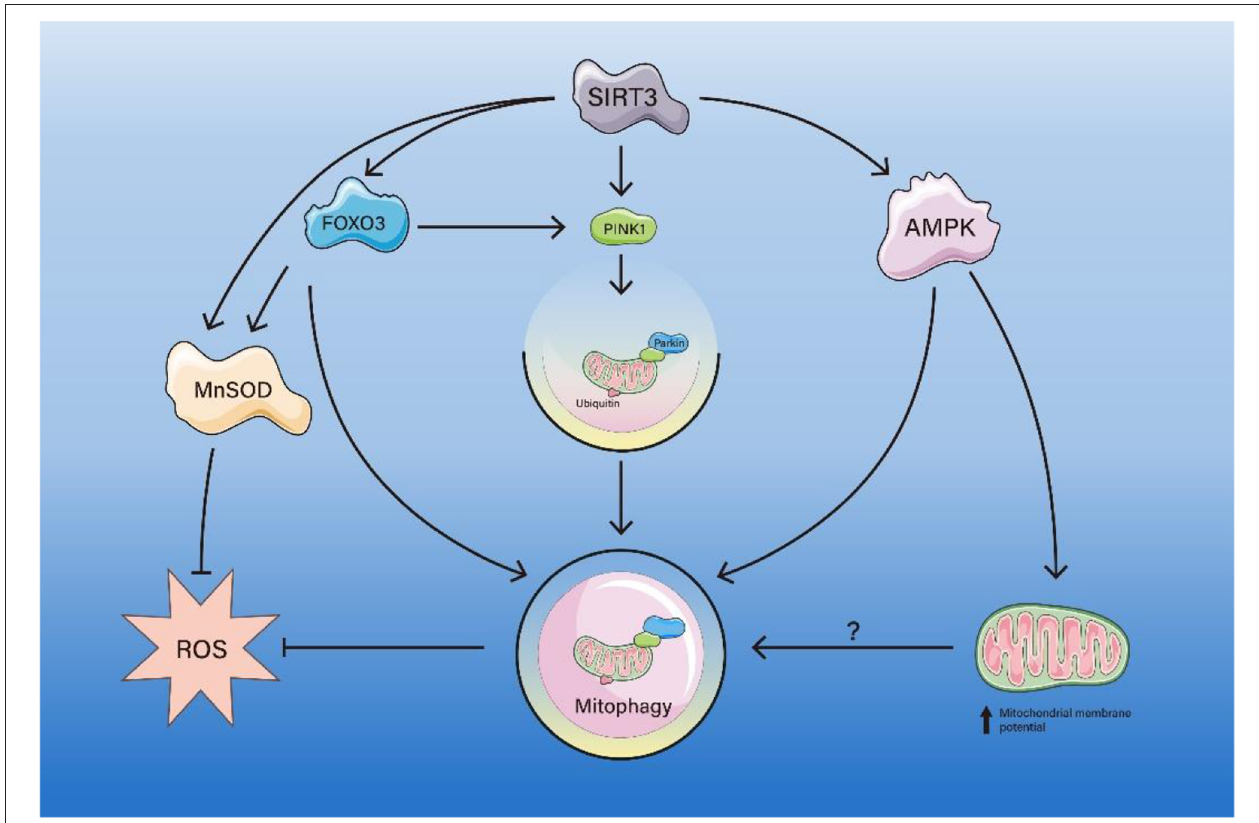
FIGURE 2 | The pathway of SIRT3-mediated mitophagy. SIRT3 deacetylates FOXO3, which activates MnSOD, inhibits ROS production. FOXO3 deacetylated by SIRT3 also enhances mitophagy directly or via the PINK1/Parkin axis, thereby inhibiting ROS production. SIRT3 enhances AMPK activity, thereby directly enhancing mitophagy or indirectly enhancing mitophagy by increasing mitochondrial membrane